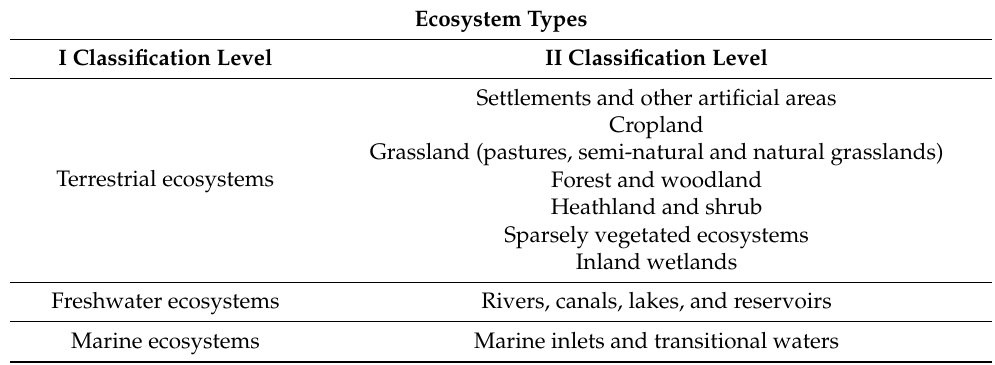
Table 1. MAES ecosystem types adopted for the realisation of the ecosystem type map by integrating Copernicus data with the LCM.